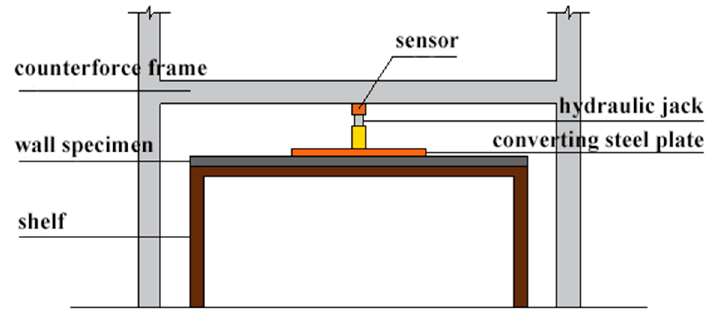
Figure 8. Loading test device (elevation view).